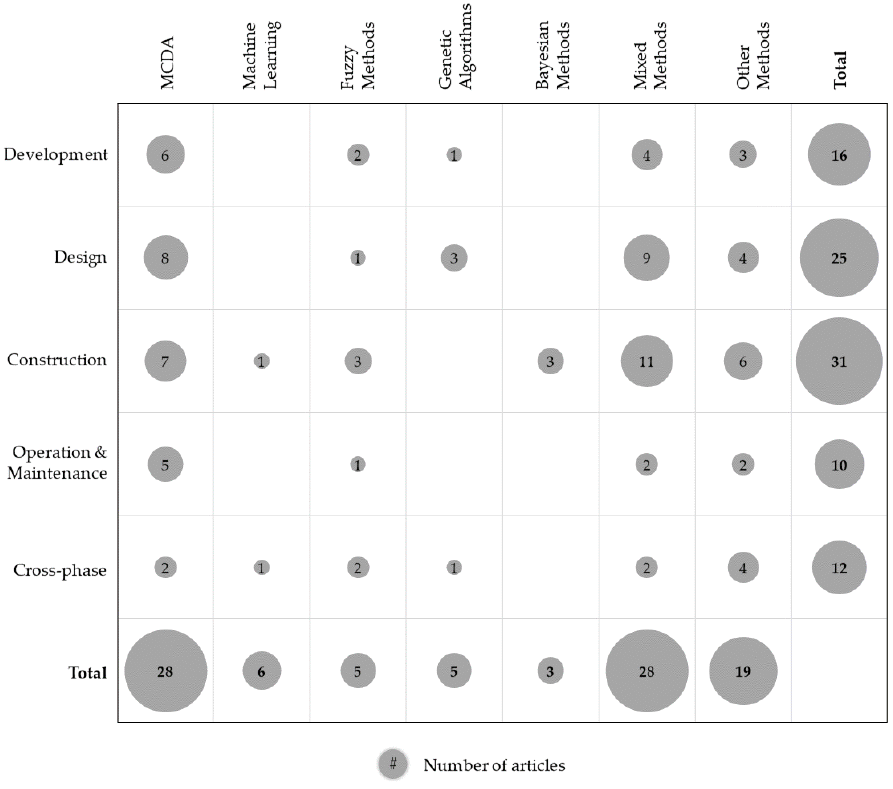
Figure 4. Number of articles per lifecycle phase and method.